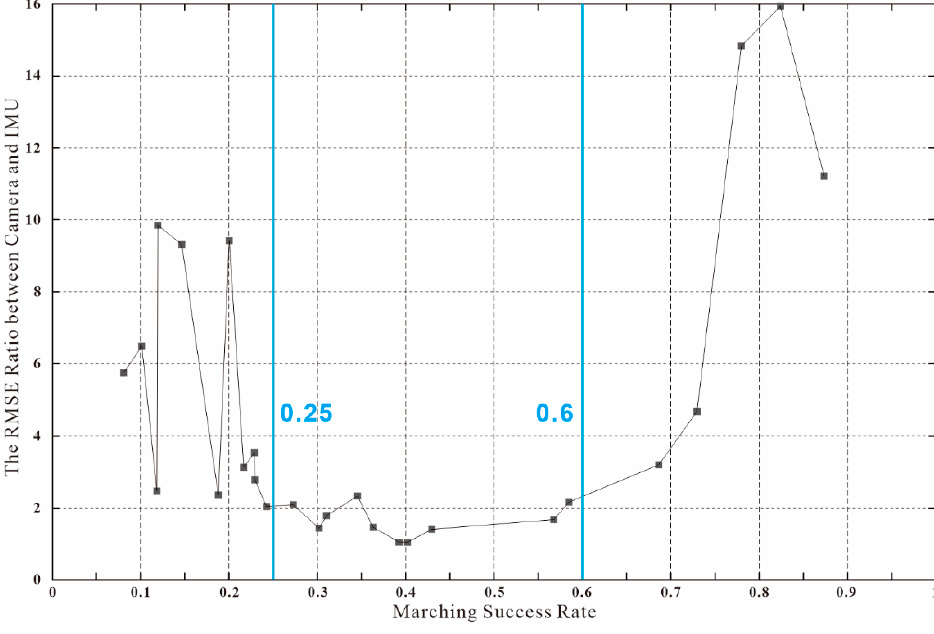
Figure 8. The RMSE ratio between the camera and